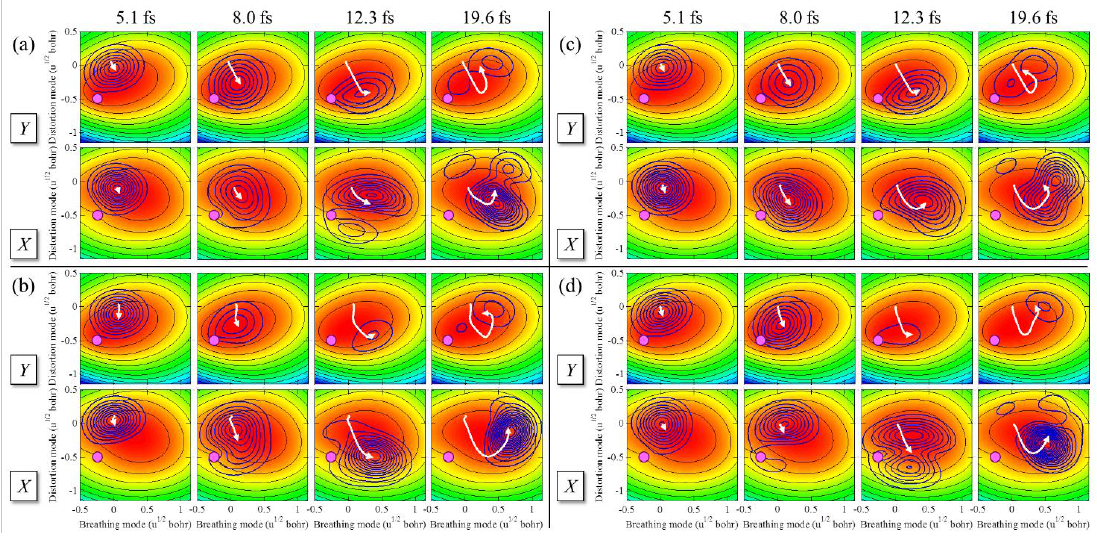
Figure 8. Propagation of the adiabatic WPs on the two-dimensional potential energy surfaces (PESs) of | X (cid:105) and | Y (cid:105) for ( a ) e (+) , ( b ) e ( − ) , ( c ) e +1 , and ( d ) e − 1 . The origin of the PESs is the optimized geometry of | G (cid:105) and the avoided crossing is designated by a circle. The bold contours represent the probability densities | ψ X ( Q , t ) | 2 and | ψ Y ( Q , t ) | 2 . The arrows indicate the motion of the center of the WPs. Modified from [56] with permission of the American Chemical Society.